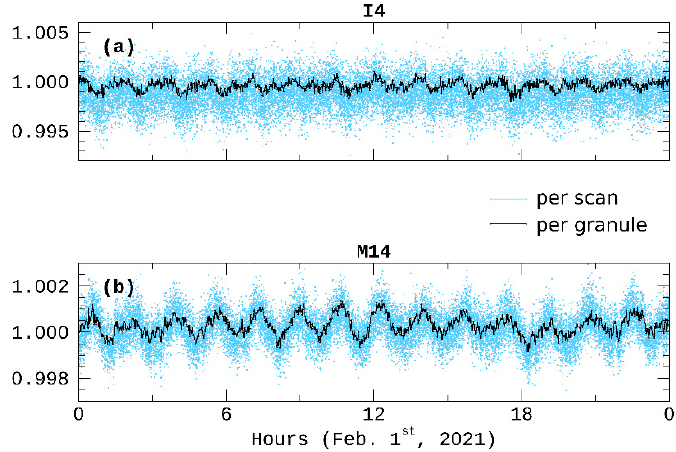
Figure 7. S-NPP VIIRS bands ( a ) I4 (detector 16, Product Order) and ( b ) M14 (detector 8, Product Order) normalized F-factors during nominal operations on 1 February 2021. Values are shown on a granule-averaged and scan-by-scan basis and are normalized to the first data point of the day. Only HAM-side A is illustrated. Note: Throughout this paper, the detectors are listed/numbered in Product Order. This means that the highest numbered detector (e.g., detector 16 for the M-bands and detector 32 for the I-bands) of a given scan is adjacent to detector 1 in the next scan. This is opposite to the prelaunch numbering convention (also known as Santa Barbara Remote Sensing (SBRS) Order), which is reversed.